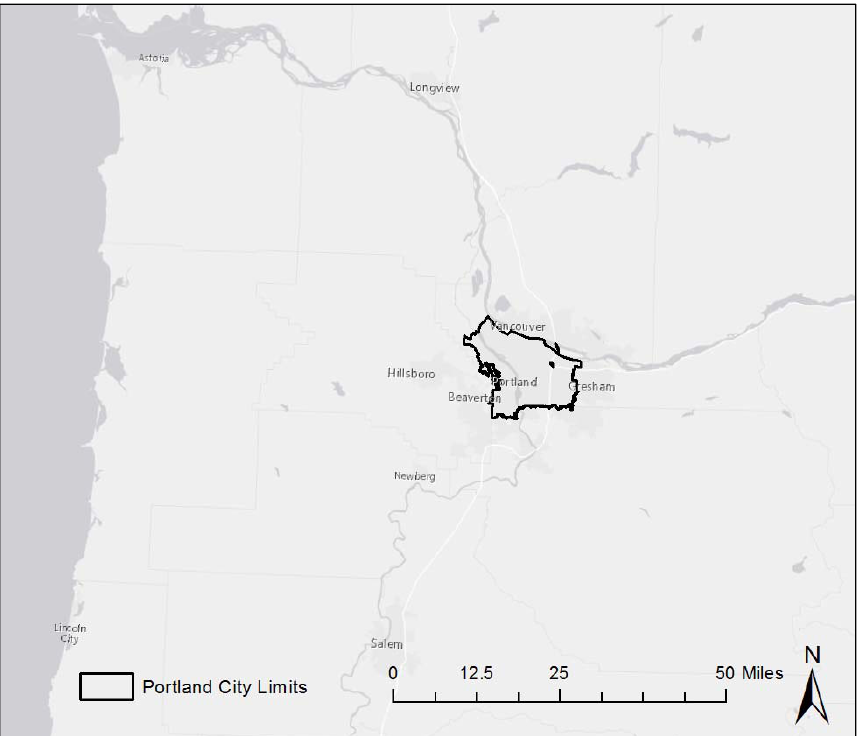
Figure 3. Context Map of Study